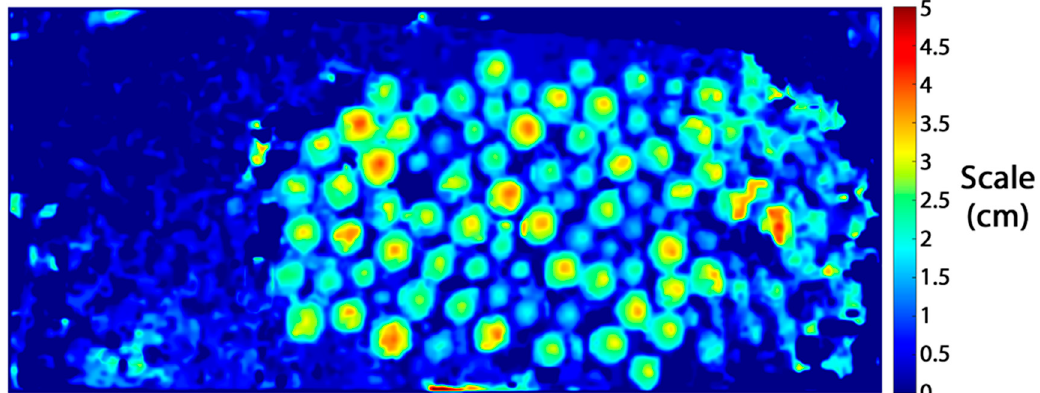
Figure 9. Scaled height map of the artificial specimen relative to the board (the elevation of the board is set to 0 cm).